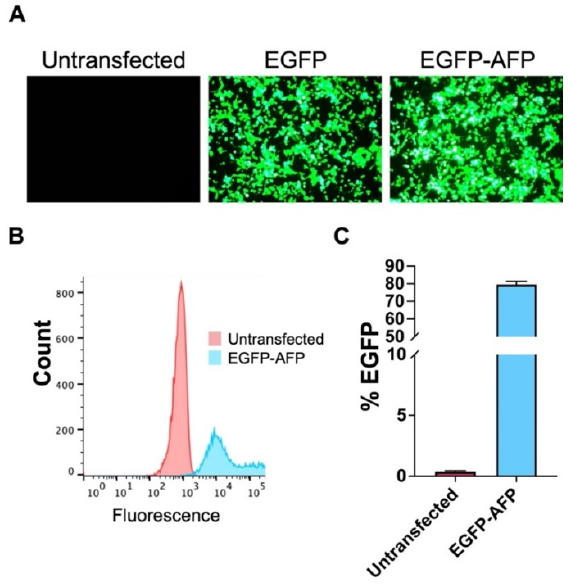
Figure 1. Transfection of HEK 293T cells. ( A ) Epifluorescent images of HEK 293T cells comparing untransfected cells and cells transfected with EGFP and EGFP–ApAFP752 (EGFP–AFP) after 48 h photographed at 100X. ( B ) Flow cytometry analysis of AFP transfection measuring transfection efficiency of EGFP–ApAFP752 gated against untransfected cell autofluorescence. ( C ) Average trans- fection efficiency (% EGFP expression) for EGFP–ApAFP752 (blue) compared to untransfected cells (magenta). Mean value ± SEM. All experiments contained three biological repeats ( n = 3), with each containing three technical